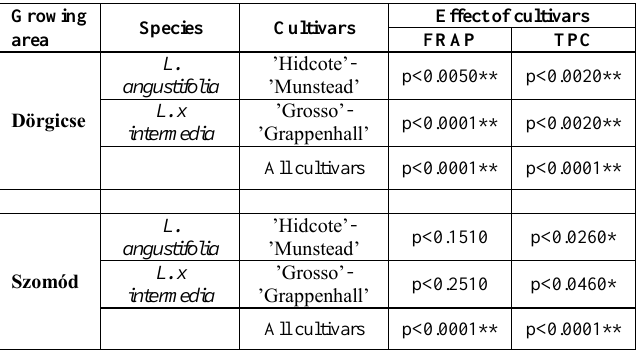
Table 2. Evaluation of the effect of cultivars on the antioxidant capacity (FRAP) and total polyphenol content (TPC) in both growing areas (Dörgicse and Szomód) involved.